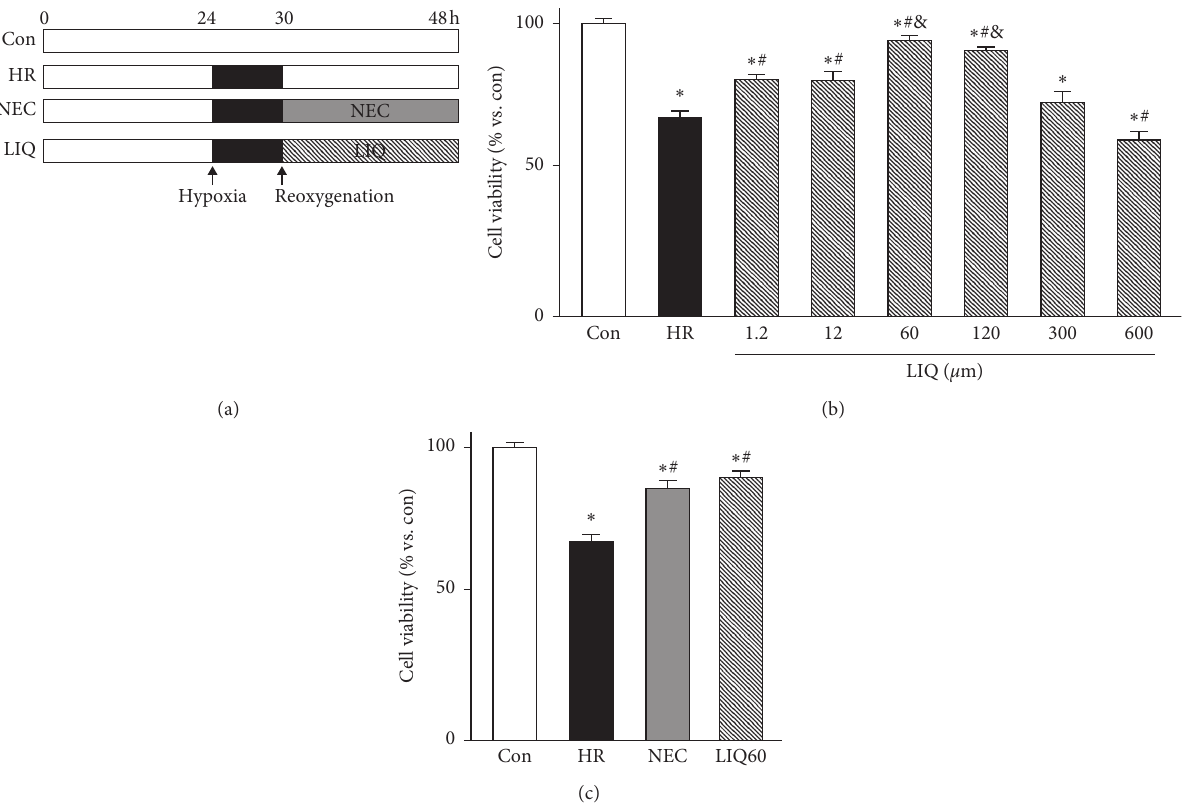
Figure 2: Experimental design and cell viability assay. (a) HR model and LIQ treatment. ((b)-(c)) The graph indicates H9C2 cell viability under different conditions and treatments. Con: normal control; HR: hypoxia/reoxygenation; LIQ: HR +liquiritin (LIQ); NEC: HR +NecroX-5 (10 μ M); LIQ60: HR +LIQ at a dose of 60 μ M; ∗ p < 0 . 05 vs. Con; # p < 0 . 05 vs. HR; & p < 0 . 05 vs. LIQ at doses of 1.2, 12, 300, and 600 μ M, n � 6 for each